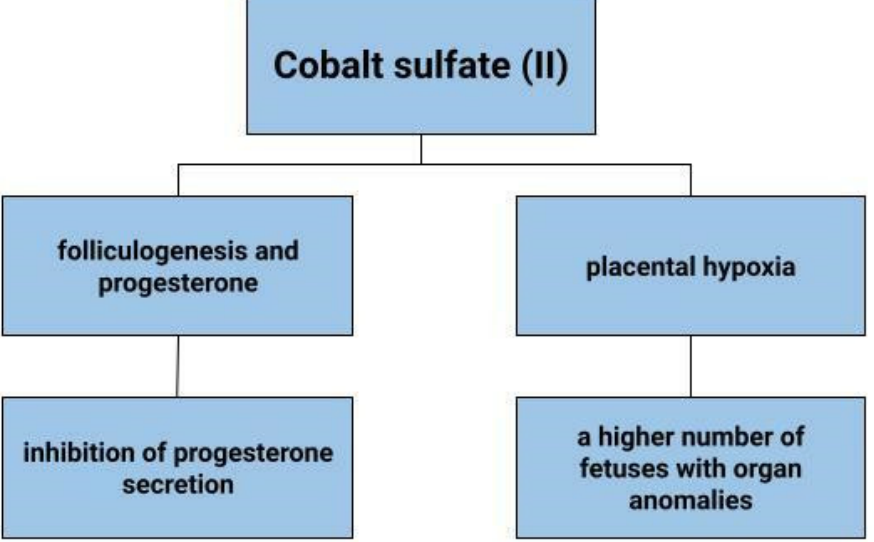
Figure 5. The role of cobalt sulfate (II) in gynecological diseases.